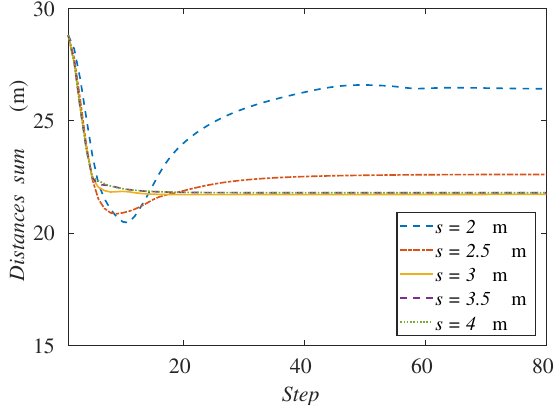
Figure 9. Sum of agents’ distances to the formation center along the simulation depending on the sensing radius.